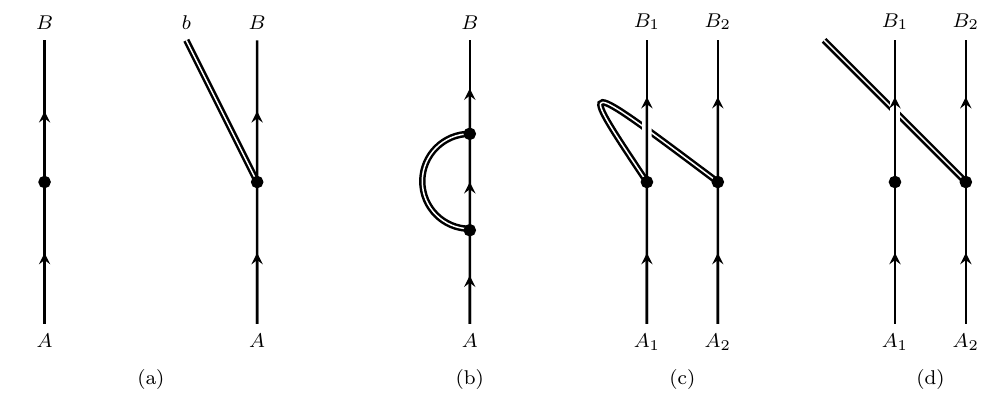
Figure 24 . Construction of C Z : (a) Two types of morphisms from A to B . (b) Composition of 2 two morphisms of the second type. (c) Tensor product of two morphisms of the second type. (d) Tensor product of a morphism of (cid:12)rst type on the left and of second type on the right will similarly involve a crossing of b line. And the tensor product of second type on left and (cid:12)rst type on right doesn’t involve any crossing.